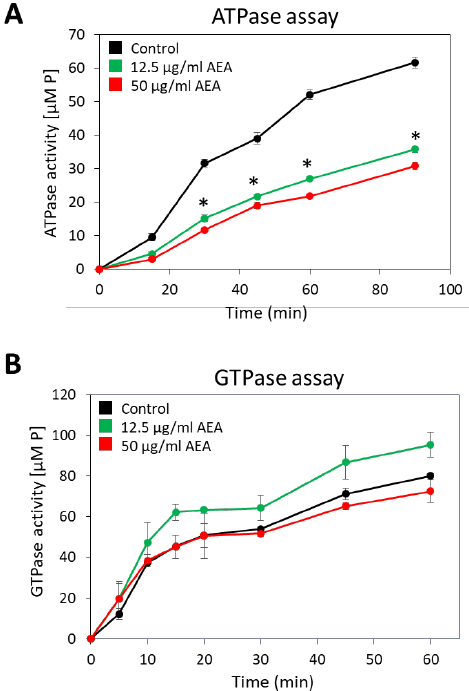
Figure 8. AEA treatment reduces membrane ATPase activity, but not that of GTPase. ( A , B ). A MDRSA CI-M culture that had reached an OD 600nm of 1 was incubated in the absence or presence of 12.5 or 50 µ g/mL AEA for 30 min, and the ATPase ( A ) or GTPase ( B ) activities of the isolated membranes were analyzed in a kinetic study using ATP or GTP as substrate, and the concentration of the released phosphate ([P]) was measured using the BIOMOL Green reagent. * p < 0.05 when comparing the AEA-treated bacteria with control